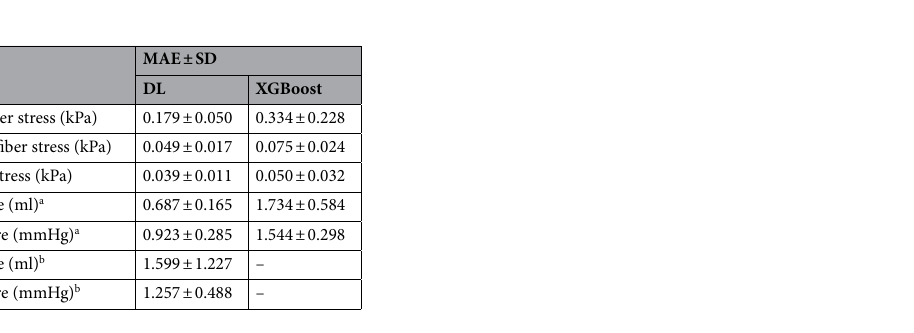
Table 1. The error results for LV stress, volume and pressure predictions. Also, DL results are compared with XGBoost from our previous study 10 . a Using 3 test FE models. b Using 6 test FE